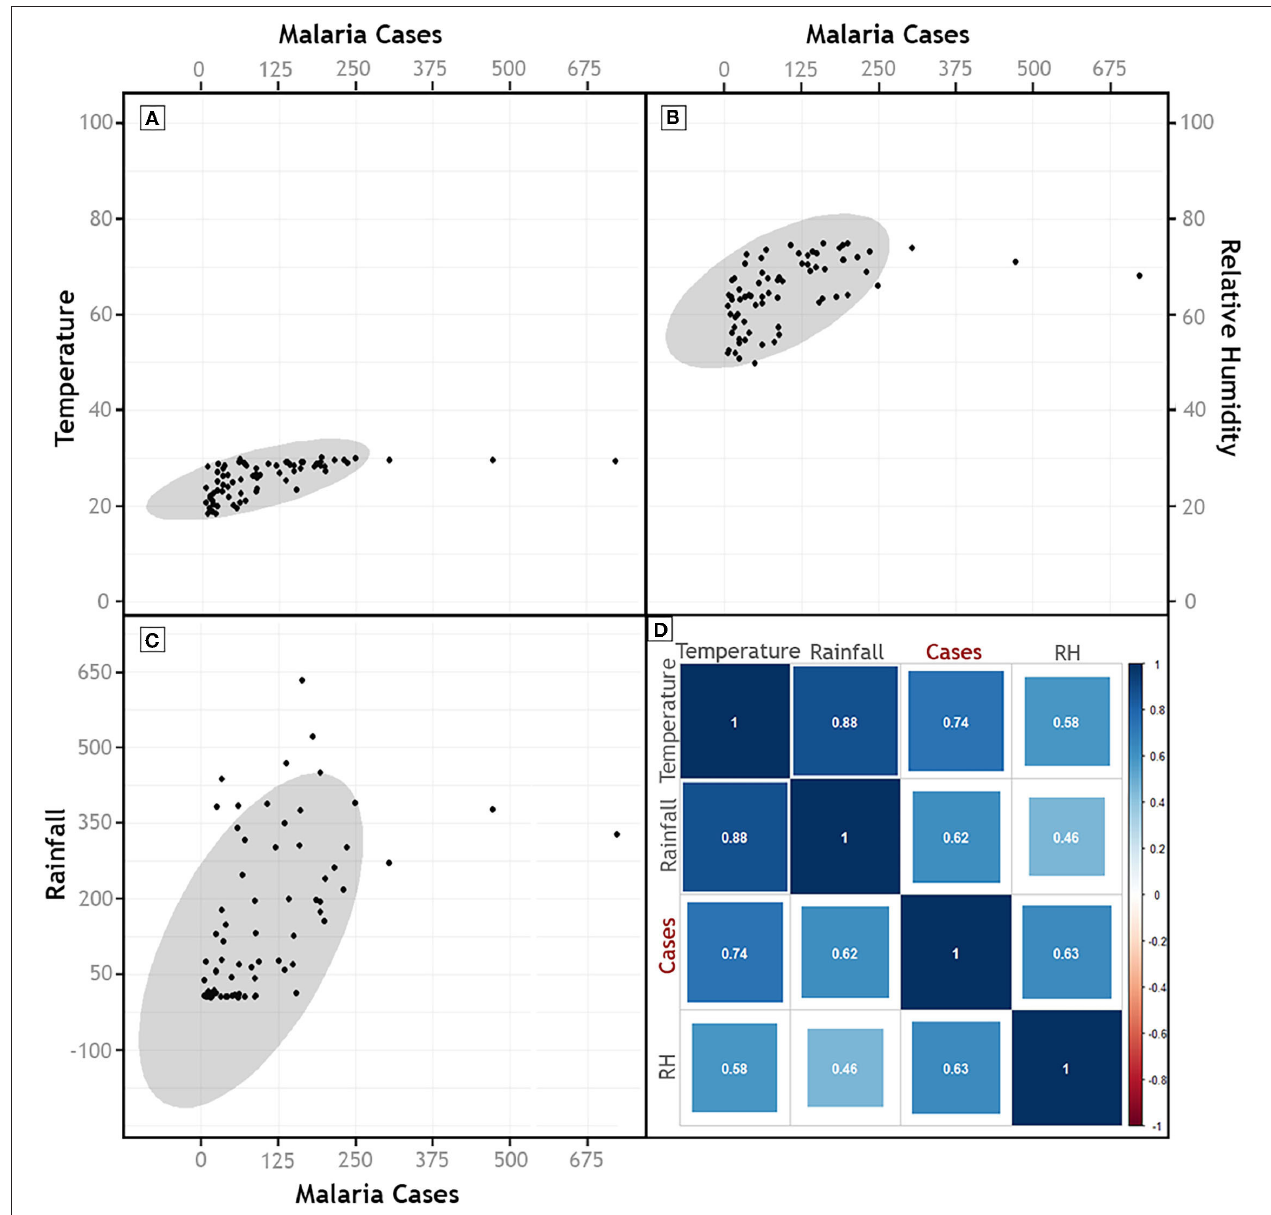
FIGURE 4 | Scatter plots of Malaria Cases and (A) Temperature, (B) Relative Humidity, and (C) Rainfall. (D) Represents the results of Spearman’s Correlation of malaria cases with monthly climatic parameters (2013–2018). Color of the correlation plot (D) indicates the magnitude of the association, whereas size of the box indicates statistical significance, with big boxes indicating high significance